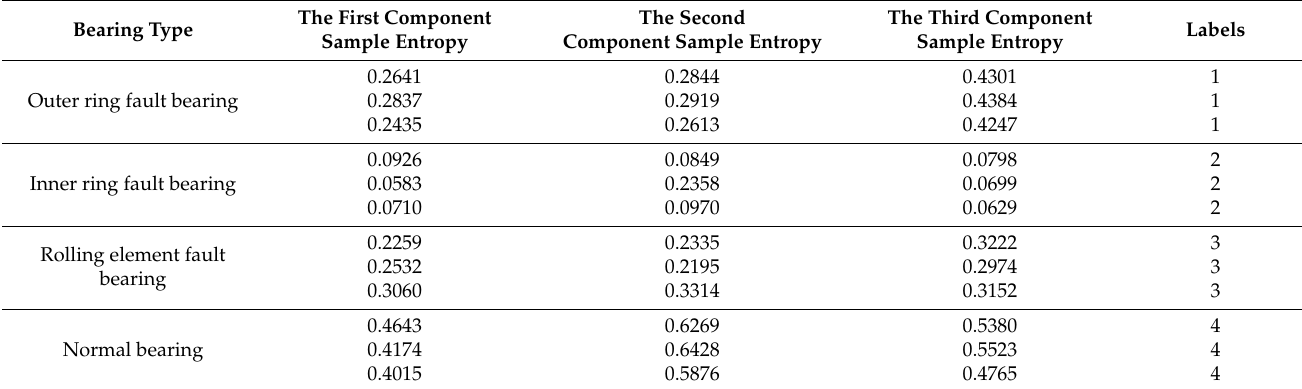
Table 5. Rolling Bearing Fault Characteristic Vector Set.